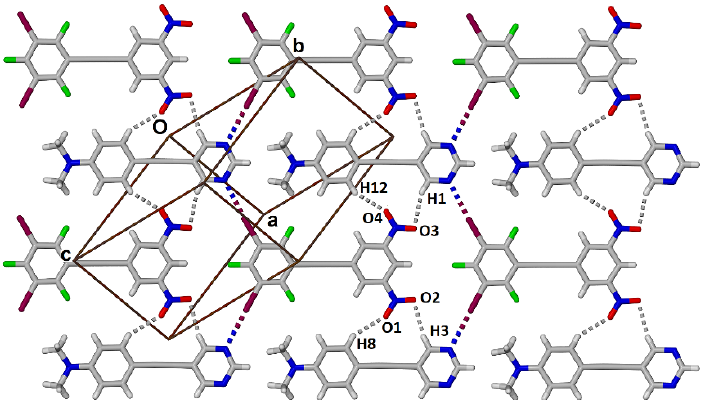
Figure 6. View of the planar sheet formed within the cocrystal 1 • 3 with halogen bonds shown as colored dashed lines and nonconventional hydrogen bonds shown as grey dashed lines.